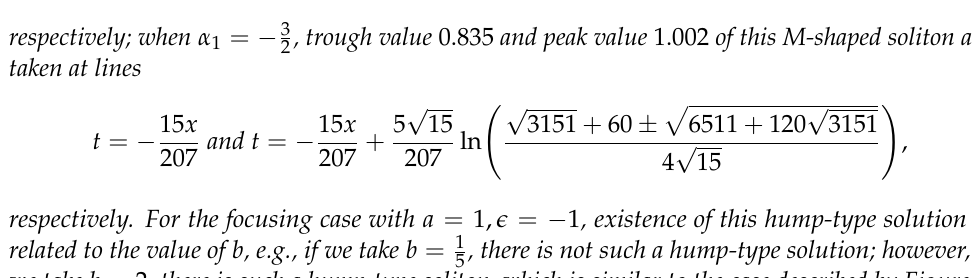
, ( c ) W-shaped soliton with α 1 = 1 2 , ( f ) dark soliton with α 1 = − 3 6